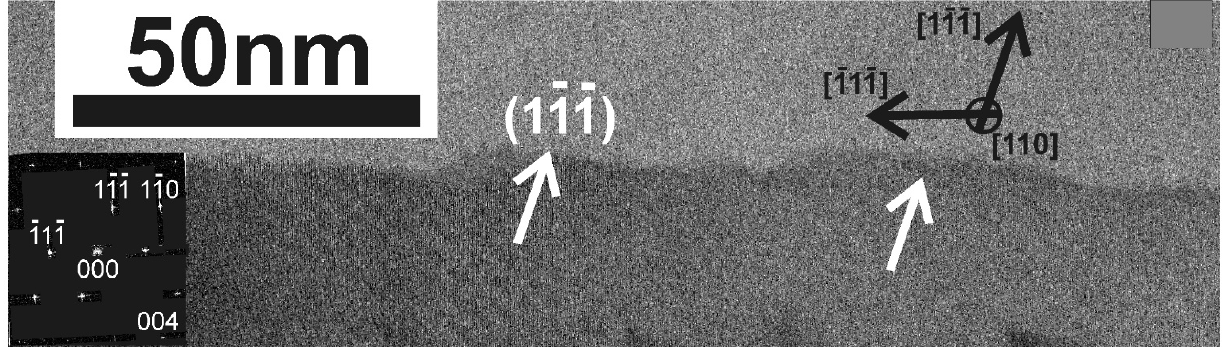
Figure 8. Cross-section TEM micrograph from fast [111] whiskers viewed in (110) section. A saw-tooth faceting of the side-walls is evident, with the longest segments of the tooth being the (111) planes.